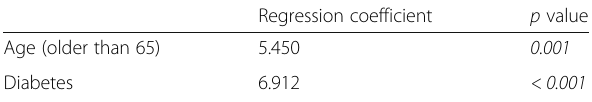
Table 5 Admitted patient characteristics and longer admission days: multivariable analysis (linear regression analysis) Regression